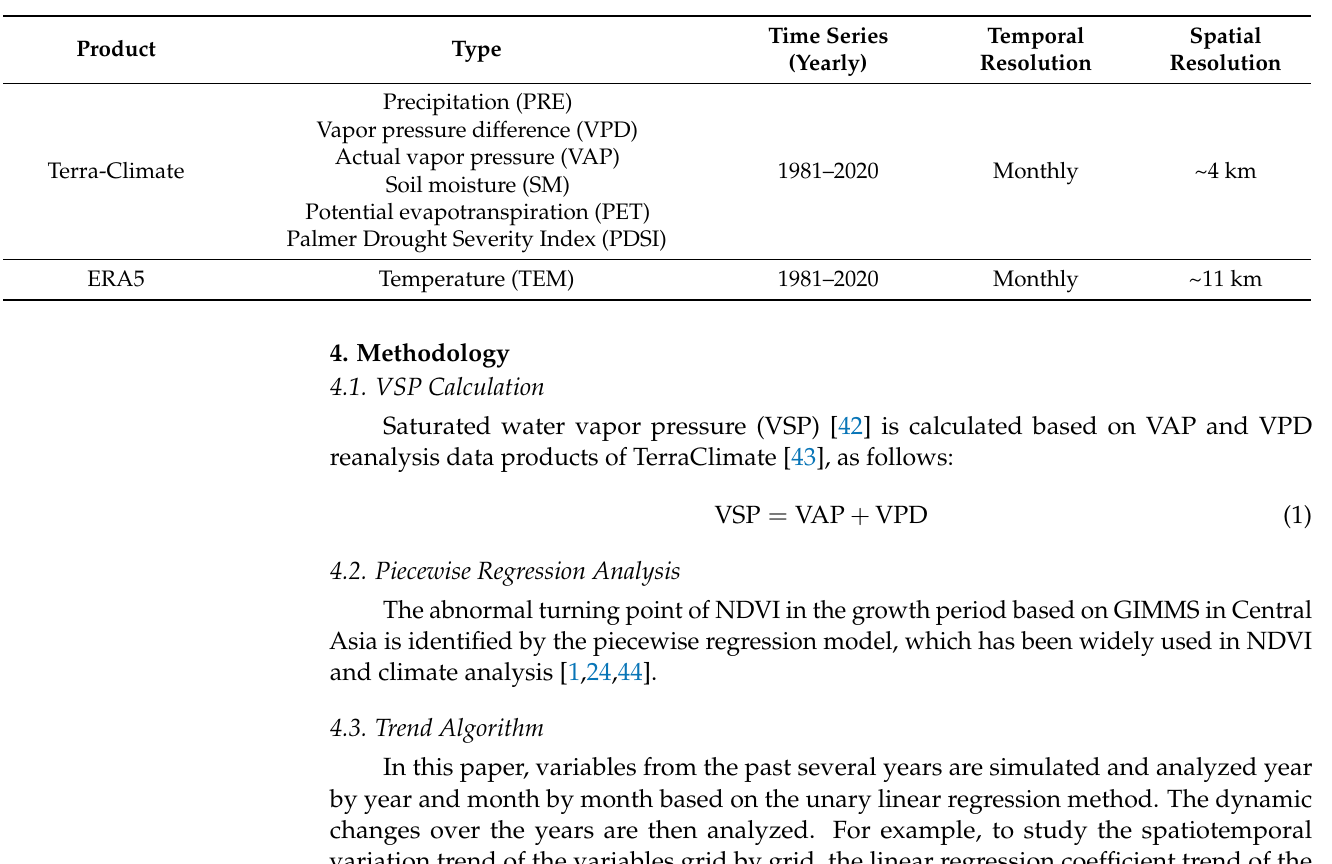
Table 2. TerraClimate and ERA5 data